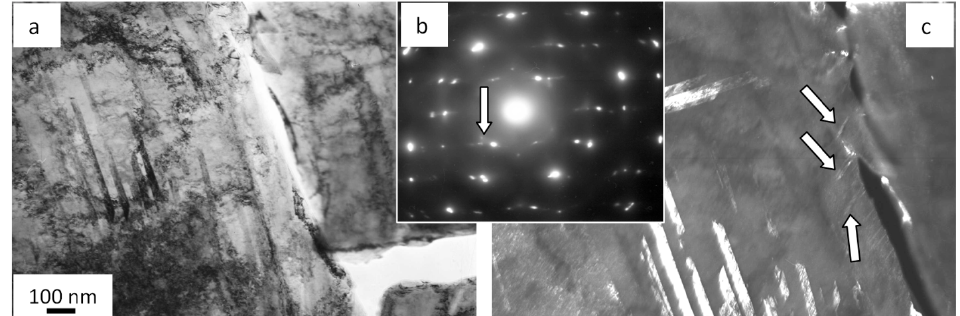
Figure 6. Crystals of ε -martensite forming close to grain boundaries on the surface of the fatigue-fractured AISI 310S steel; ( а ) bright field; ( b ) electron diffraction micropattern, with the arrow indicating reflexes where a dark field is obtained; ( c ) dark field recorded in the closely located reflexes [111] γ -Fe + [002] γ -Fe + [101] ε -Fe. The arrows ( c ) point at ε -martensite crystals.